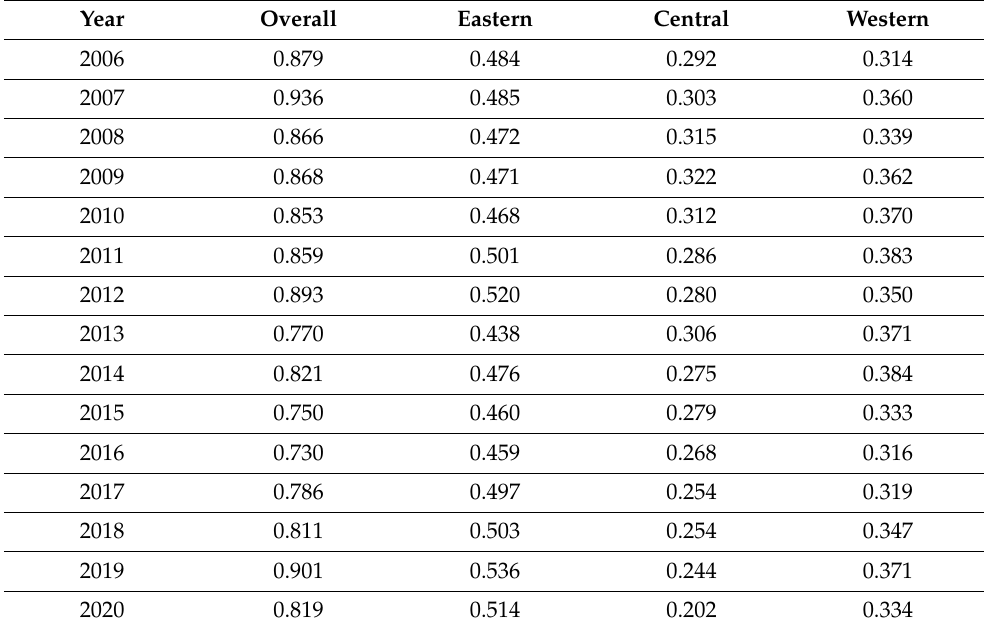
Table 5. Convergence of the livelihood resilience of rural residents in China by region. Overall